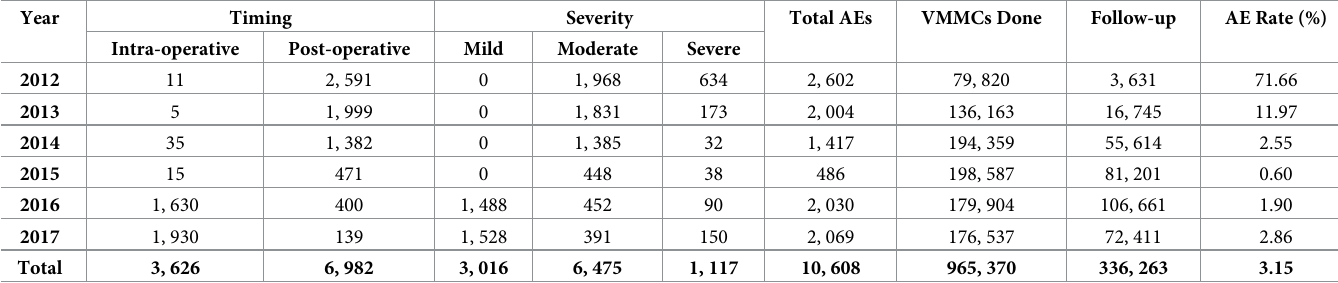
Table 3. Adverse events rates.